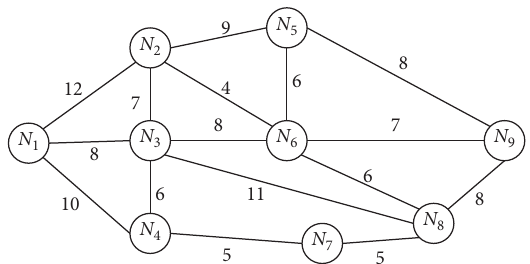
Figure 3: Road network topology